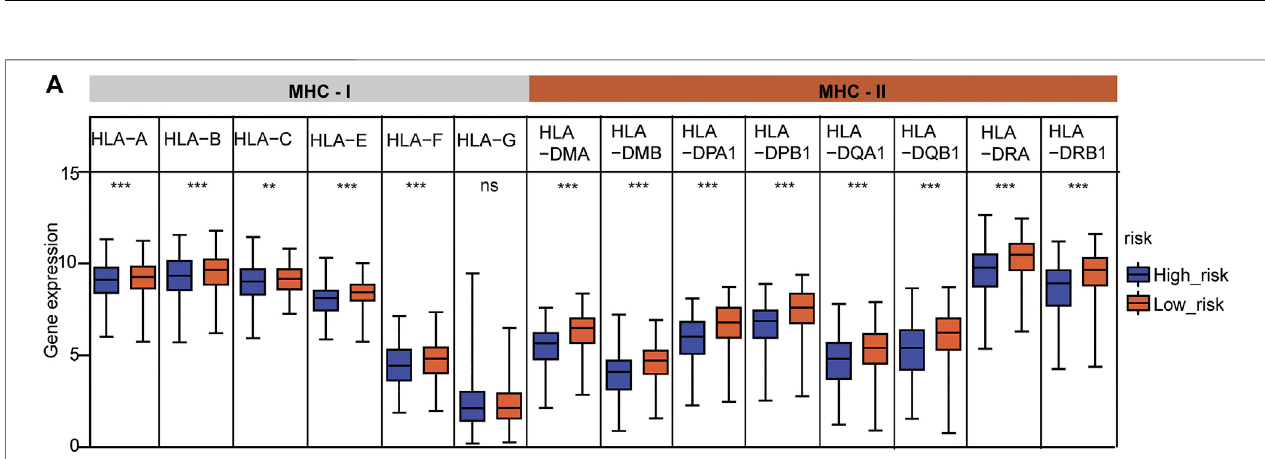
FIGURE8| HLAgeneexpressionanalysisbetweenthetworisksubtypes. (A) HLAfamilyexpressionanalysisinthetworiskgroups.Thestatisticalsigni fi cancewas calculated via t -test, ** p < 0.01 and *** p < 0.001.